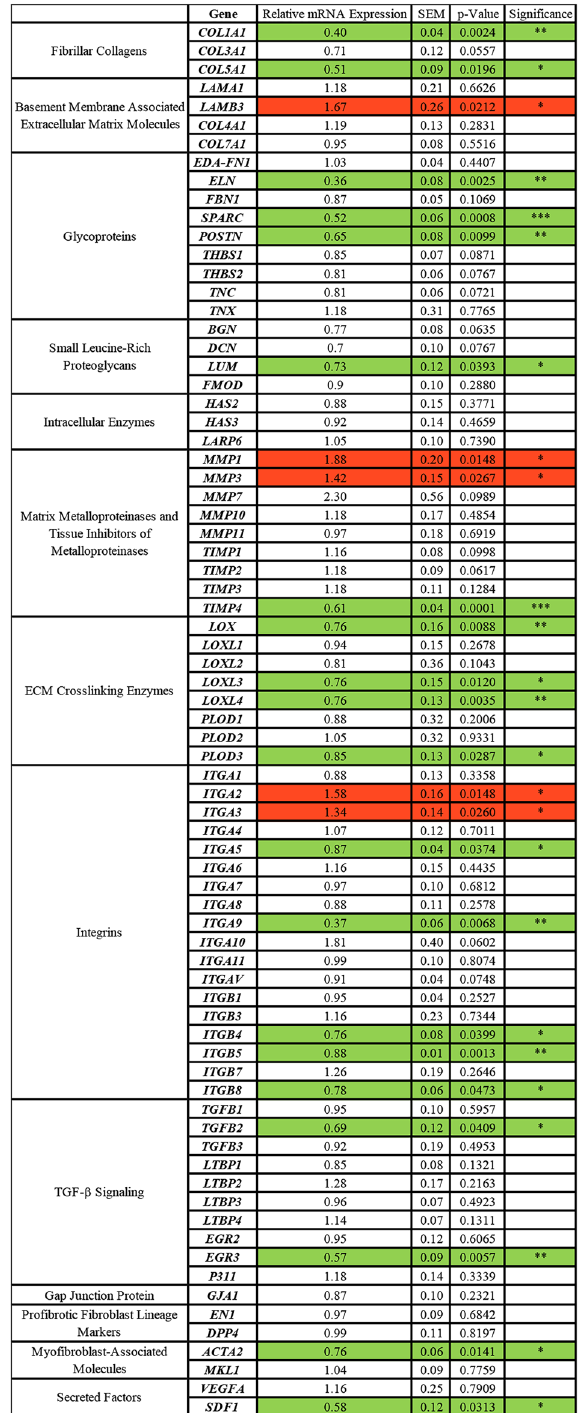
Figure 3. Fibroblast gene expression is modulated by MMC culture condition. Table shows GFBL mRNA expression (mean + /− SEM) of 75 genes in MMC relative to nMMC culture condition after 14 days analyzed by RT-qPCR. Cell color highlights statistically significant downregulation (green) or upregulation (red) of mRNA expression in MMC compared to nMMC culture condition. Statistical testing was performed by independent samples t-test (*p < 0.05; **p < 0.01; ***p < 0.001), n = 4–7 repeated